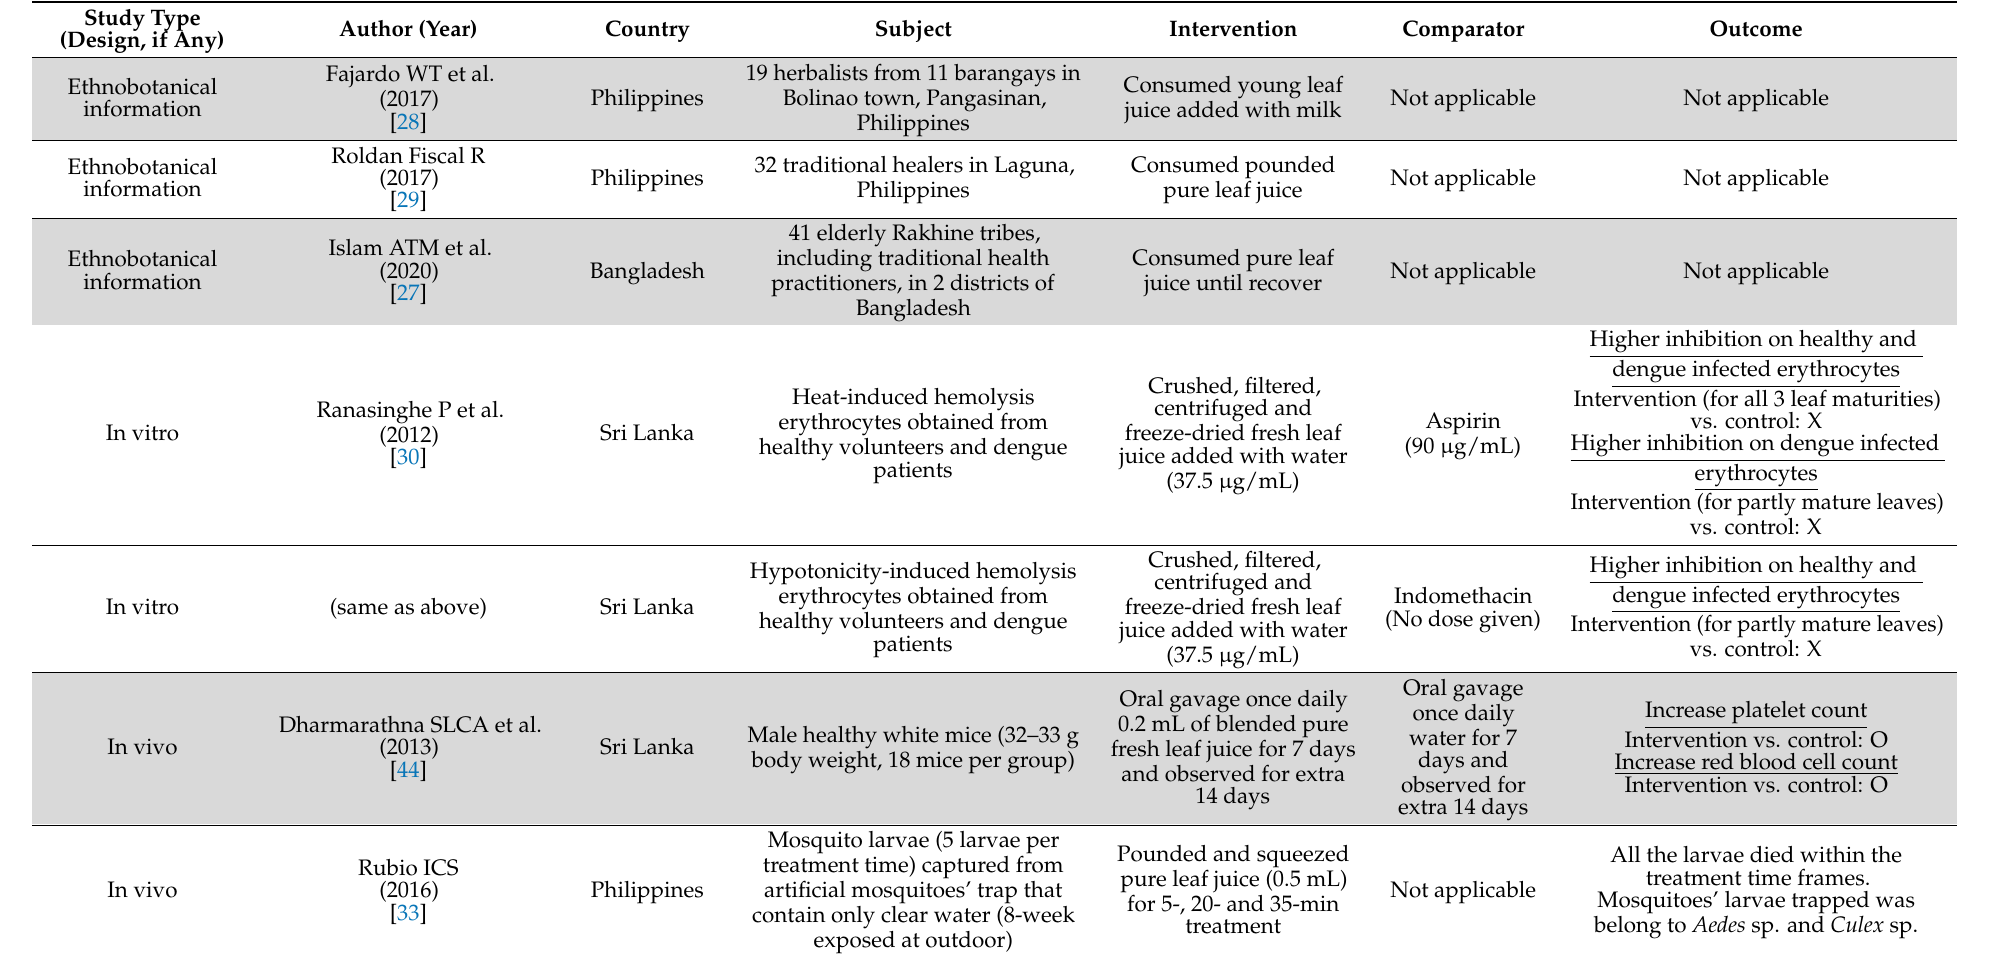
Table 2. Summary of included studies using Carica papaya leaf juice as dengue